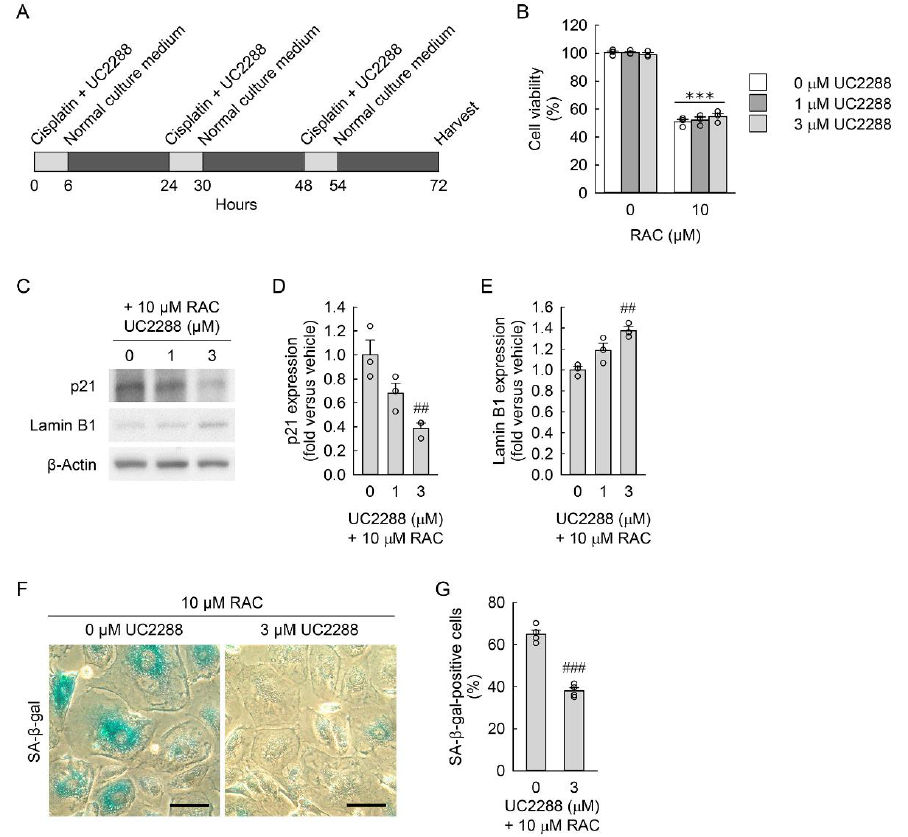
Figure 4. Inhibition of p21 reduces cellular senescence induced by repeated administration of cisplatin (RAC). ( A ) Experimental timetable for RAC and UC2288, a cell-permeable p21 inhibitor, in normal rat kidney fibroblast NRK-49F cells. The cells were treated with 0, 1, or 3 µ M UC2288 in 0.1% dimethyl sulfoxide and 10 µ M cisplatin in normal culture media for 6 h, and the media were replaced with normal culture media, followed by incubation for 18 h. The experiment was repeated three times, and finally the cells were harvested at 72 h after the first treatment. ( B ) Cell viability was measured using 3-(4,5-dimethyldiazol-2-yl)-2,5-diphenyltetrazolium bromide dye ( n = 3 experiments, 3 wells per experiment). Data are presented as mean ± standard error of the mean with individual data points. Statistical significance was determined by two-way analysis of variance (ANOVA) followed by Tukey’s post hoc test (effect of RAC, F 1,12 = 1149.211, p < 0.001; effect of UC2288, F 2,12 = 0.285, p = 0.757; interaction between RAC and UC2288, F 2,12 = 1.188, p = 0.338). *** p < 0.001 versus 0 µ M RAC. ( C ) Representative Western blots of p21 and lamin B1 expression. Anti- β -actin antibody was used as a loading control of Western blot analysis. ( D , E ) Quantifications of p21 and lamin B1 expression using the Azure c300 imaging system (Azure Biosystems, Dublin, CA, USA) ( n = 3 experiments). ( F ) Representative images of senescence-associated β -galactosidase (SA- β -gal)-stained cells at × 400 magnification using the Olympus IX70 inverted microscope (Olympus, Tokyo, Japan), DP Controller camera (Olympus), and DPManager imaging software (Olympus). Scale bar, 50 µ m. ( G ) The percentage of SA- β -gal-positive cells was counted at × 200 magnification ( n = 4 experiments). ( D , E , G ) Data are presented as mean ± standard error of the mean with individual data points. Statistical significance was determined by ANOVA followed by Tukey’s post hoc test (( D ), F 2,6 = 11.535, p = 0.009; ( E ) F 2,6 = 14.163, p = 0.005; ( G ) F 1,6 = 112.567, p < 0.001). ## p < 0.01, ### p < 0.001 versus 0 µ M